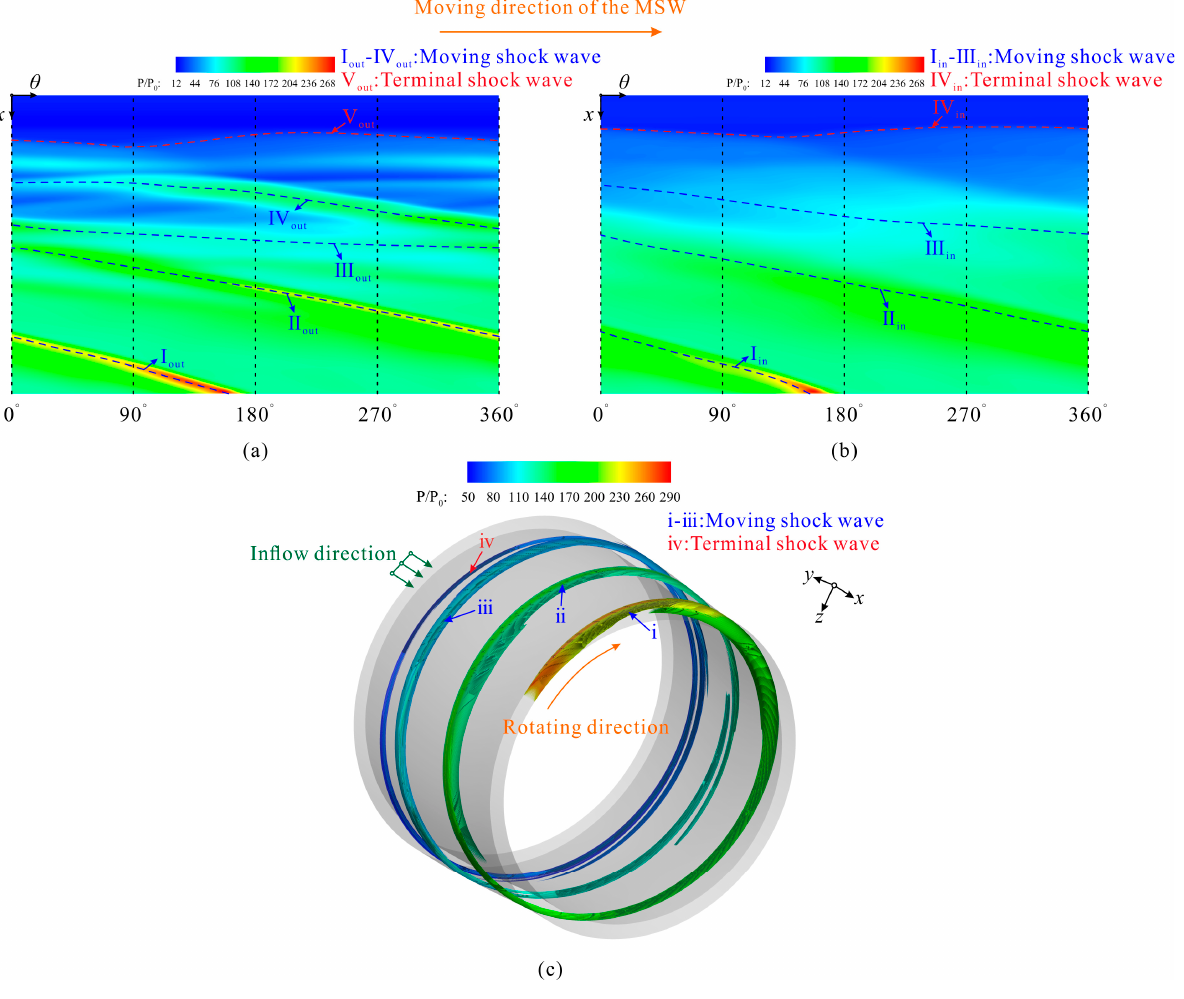
Figure 6. Shock wave structures. ( a ) Pressure contour on the outer wall after the coordinate change. ( b ) Pressure contour on the inner wall after the coordinate change. ( c ) Three-dimensional schematic diagram of the moving shock wave and the terminal shock